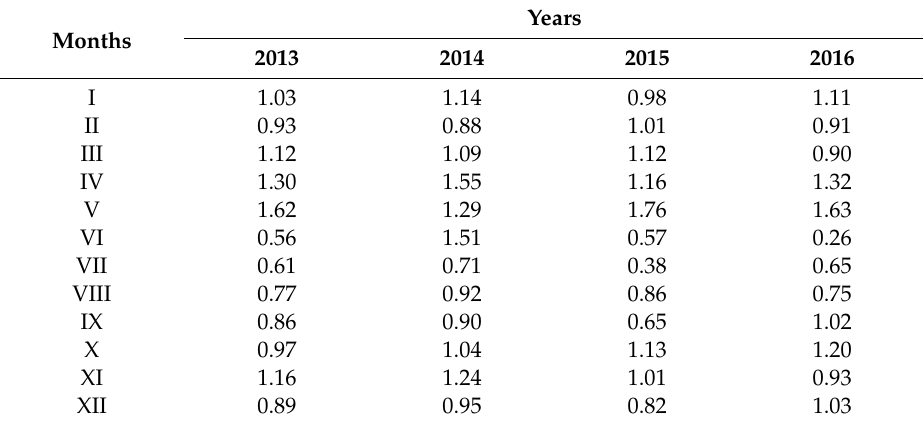
Table 6. The hydrothermal index (K) during the growing seasons in